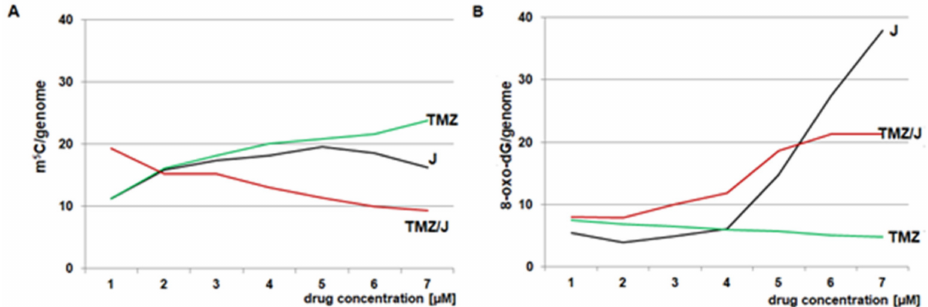
Figure 8. The juglone and TMZ alone or in combination affects DNA (m 5 C) methylation ( A ) and DNA (8-oxo-dG) oxidation ( B ). The concomitant application of both drugs induces DNA hypomethylation and hyper DNA oxidation. Drug concentration: 0, 0.5, 10, 25, 50, 100, 150 µ M for 1–7 concentration points,